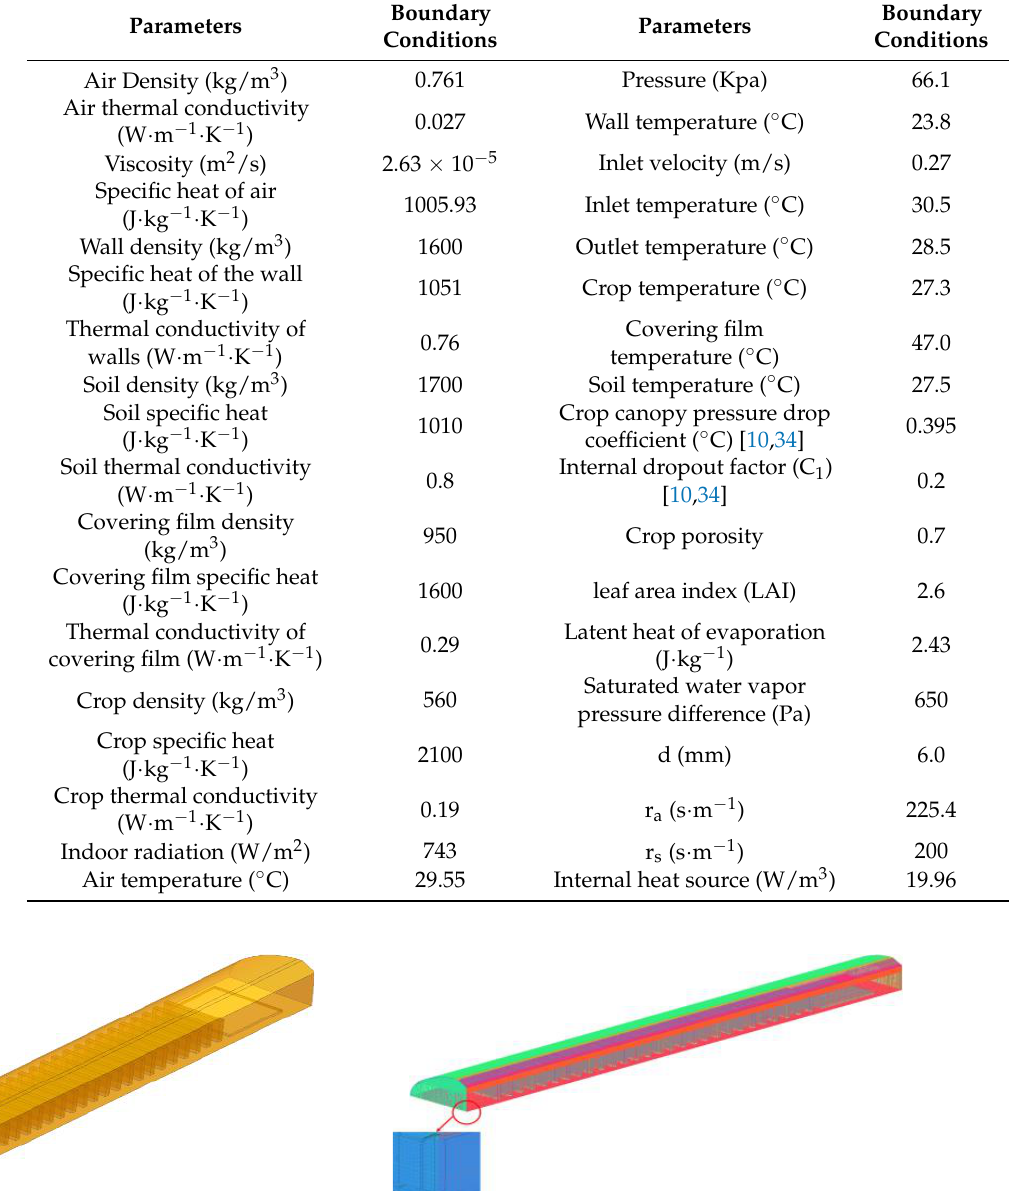
Table 2. Basic parameters and boundary condition settings.